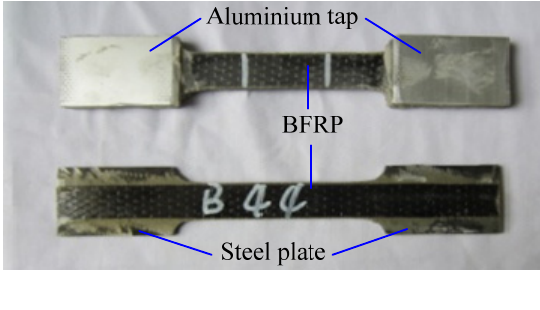
Figure 3. BSP specimens with and without aluminum tabs.